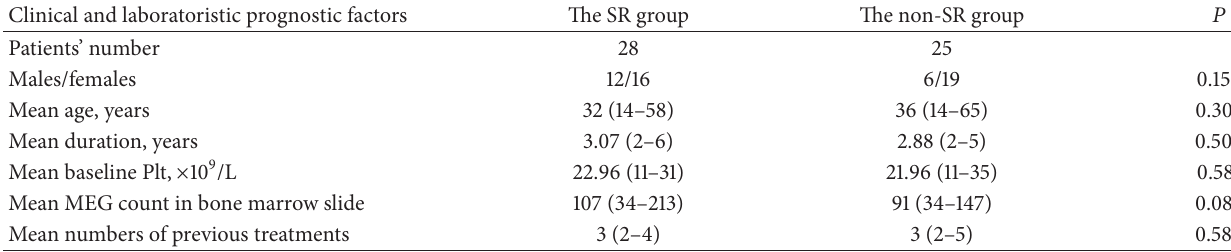
Table 3: Comparison of prognostic factors between sustained responsive group and nonsustained responsive group.